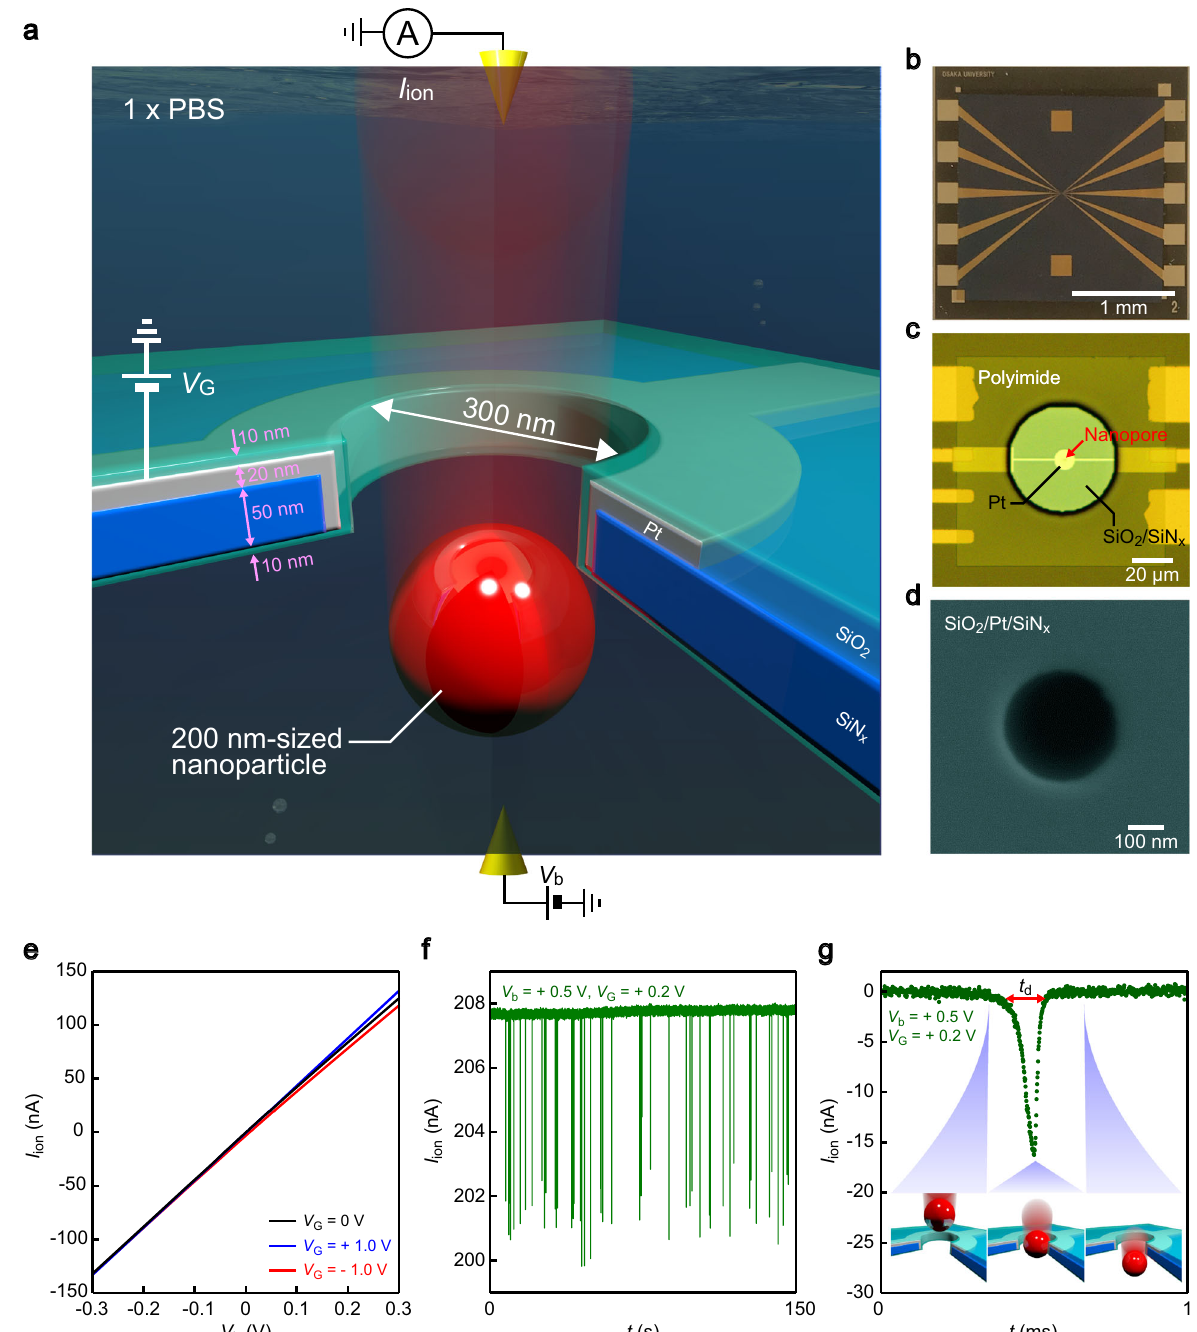
Fig. 1 Single-nanoparticle detections using a surround gate nanopore. a A schematic model depicting electrophoretic translocation of a 200 nm-sized carboxylated polystyrene nanobead through a 300 nm diameter surround-gate nanopore under the applied cross-membrane V b and gate voltage V G . Optical images of the nanopore chip showing an overview ( b ) and a magni fi ed view at the center ( c ). The gate voltage was added to the Pt surround gate via the microelectrodes. Entire surface except the 50 μ m region around the nanopore was coated with a thick polyimide layer for lowering capacitance- induced high-frequency noise of the cross-membrane ionic current I ion . d A scanning electron micrograph of the 300 nm-sized gating nanopore. e I ion versus V b characteristics in 1 × PBS under different V G conditions. A partial I ion versus time ( t ) trace ( f ) and a close view of a resistive pulse ( g ) occurred upon a nanoparticle passed through the nanopore. The width of the signal t d represents the time required for the particle to move through the channel. The base current is offset to corresponding noise spectra (Fig. 4c) as stronger 1/ f character- istics at V G = − 1.05 V attributed to the more prominent sto- chastic motions of the trapped particles. We further investigated the vibration behavior by deriving the time-course change in the particle position z from the I ion signals. (Fig. 5a) 40 . The obtained z versus I ion pulse was then normalized